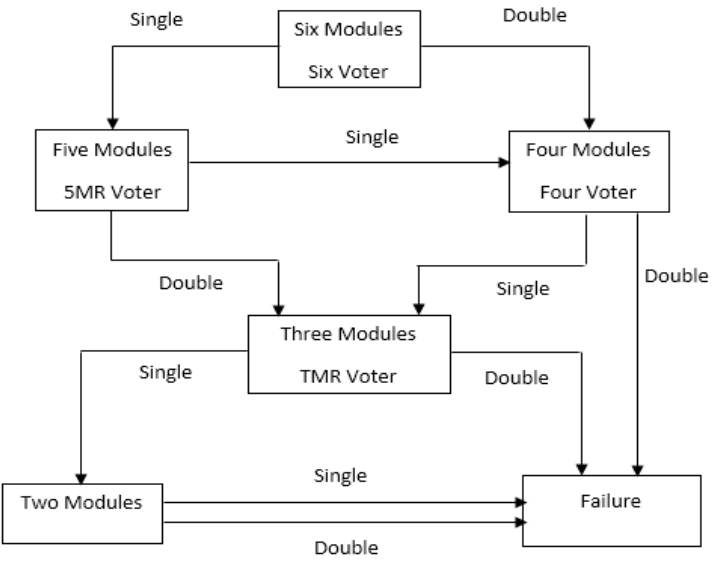
Figure 1. Hexa modular redundancy (6MR) flow chart.